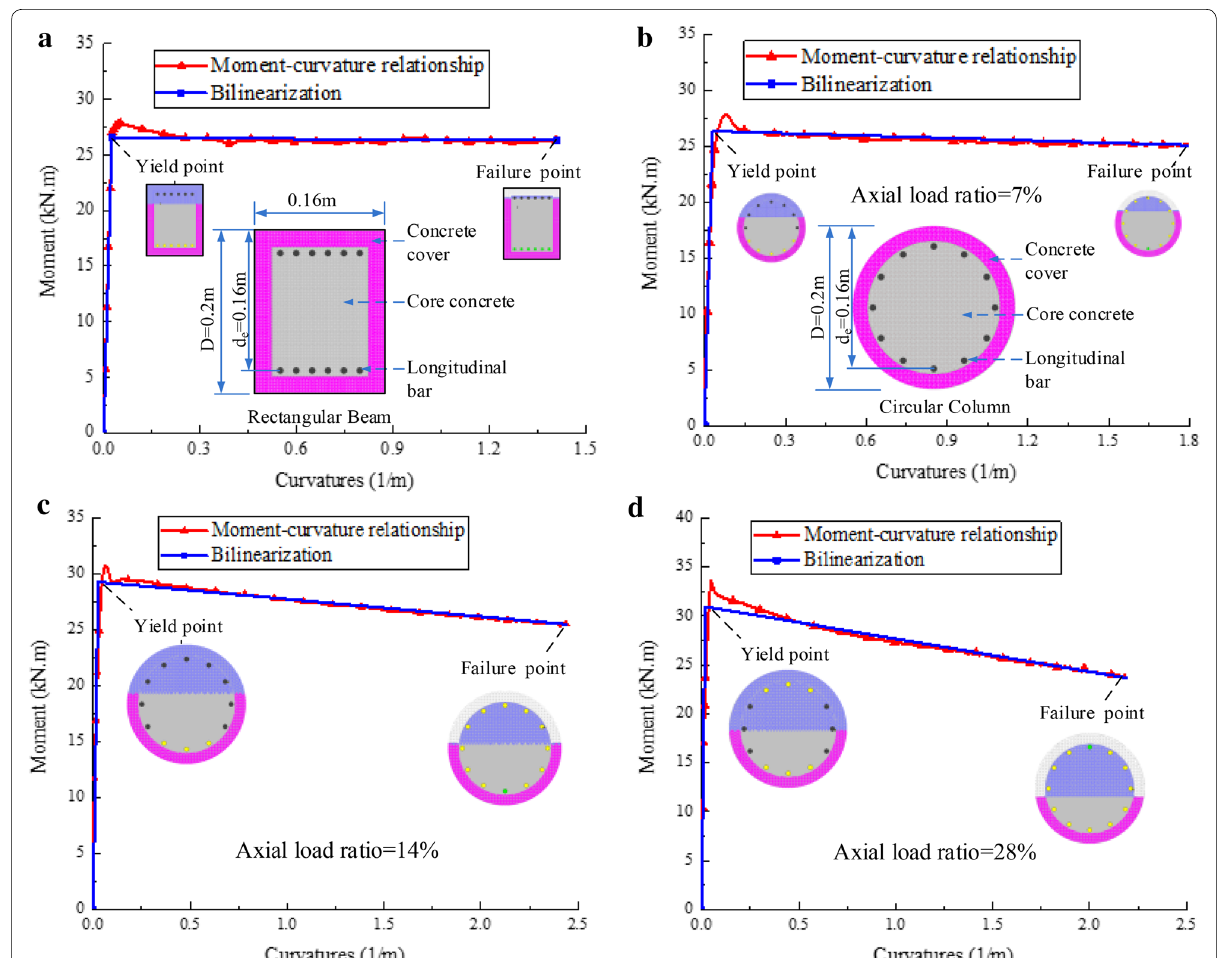
Fig. 3 Moment-curvature diagram of RC member: a rectangular RC beam; b circular column with axial load ratio of 7%; c circular column with an axial load ratio of 14%; d circular column with an axial load ratio of